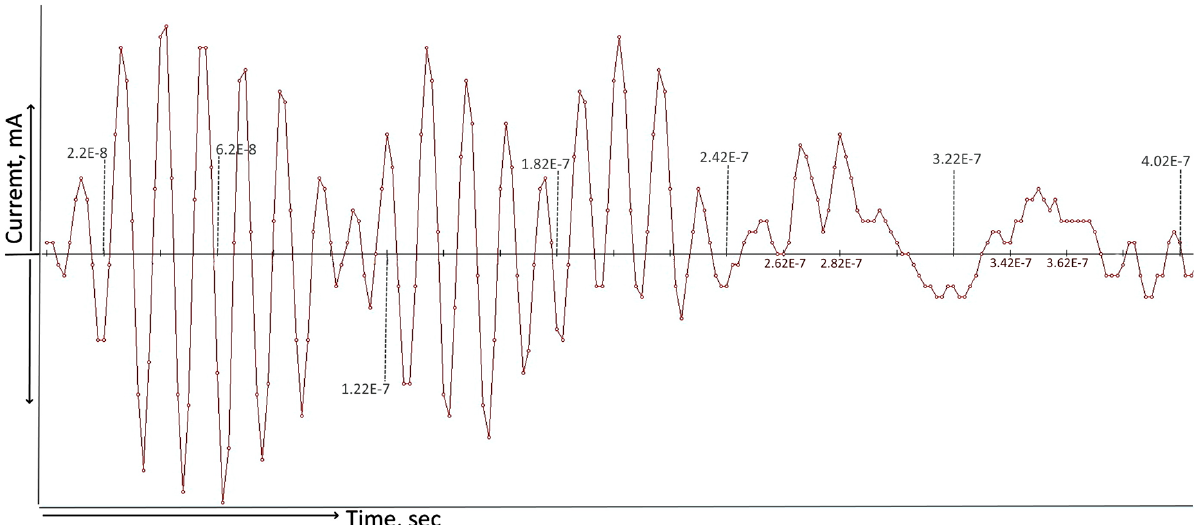
Figure 11. Graphical relationship between the changes in the electromagnetic radiation from the glow discharge plasma obtained at the output of the ADC.